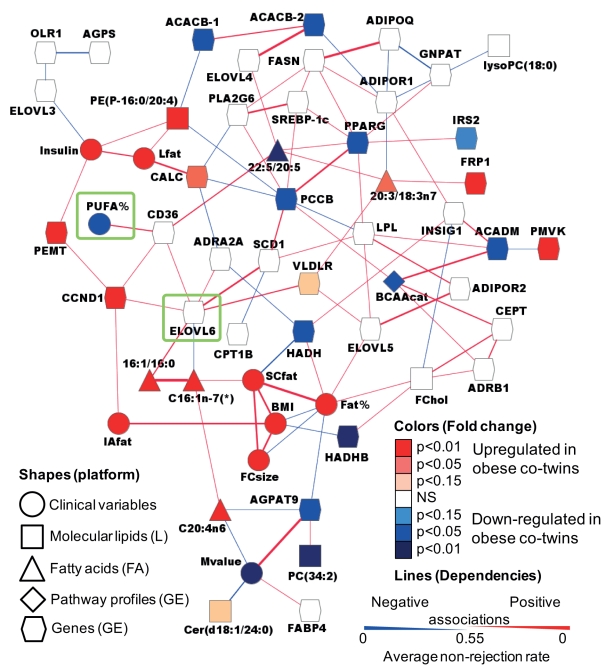
Regulation of lipid remodeling in adipose tissue.A dependency network was constructed from selected gene expression,
clinical, and lipidomic data from twin pairs discordant for BMI. Node
shapes represent different types of variables and platforms (L, UPLC-MS
lipidomics; FA, fatty acid gas chromatography; GE, gene expression),
node color corresponds to significance and direction of regulation (full
data in Table S4), and line width is proportional to strength of
dependency. The variables are connected by an edge if and only if their
partial correlation is significantly non-zero. PUFA percent and the
nearest network hub (Elovl6) are highlighted with green squares. The
cutoff for the presence of edge was set at 0.55 by the average
non-rejection rate, i.e., an edge in the graph tested positive in
55% of the 500 samplings.